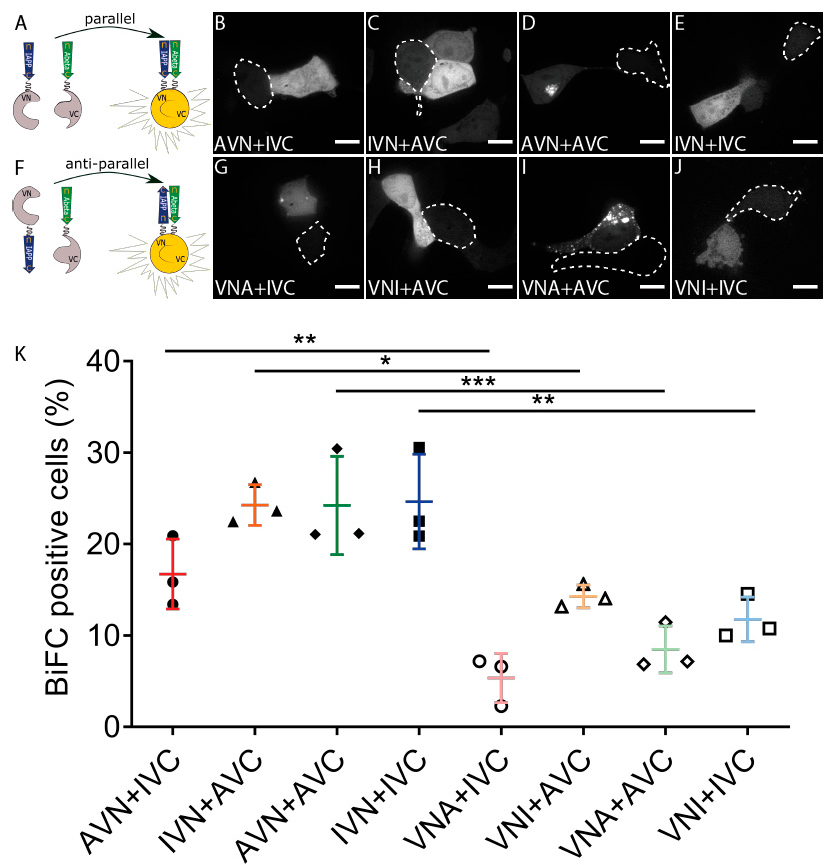
Figure 1. A β and IAPP prefer parallel binding over antiparallel binding in living HEK293 cells. ( A ) Schematic drawing of parallel binding in BiFC. Confocal images of BiFC-positive cells with the par- allel binding of A β and IAPP in ( B ) AVN + IVC, ( C ) IVN + AVC, ( D ) AVN + AVC, and ( E ) IVN + IVC. ( F ) Schematic drawing of antiparallel binding in BiFC. Confocal images of BiFC-positive cells with antiparallel binding of A β and IAPP in ( G ) VNA + IVC, ( H ) VNI + AVC, ( I ) VNA + AVC, and ( J ) VNI + IVC. Dotted circles denote BiFC-negative cells. ( K ) Proportions of BiFC-positive cells in both parallel and antiparallel settings were determined by flow cytometry. Scale bars: 10 µm. Results were analysed by one-way ANOVA with Bonferroni’s post hoc analysis and presented as the mean ± SD, * p < 0.05, ** p < 0.01, and *** p < 0.001, n = 3.